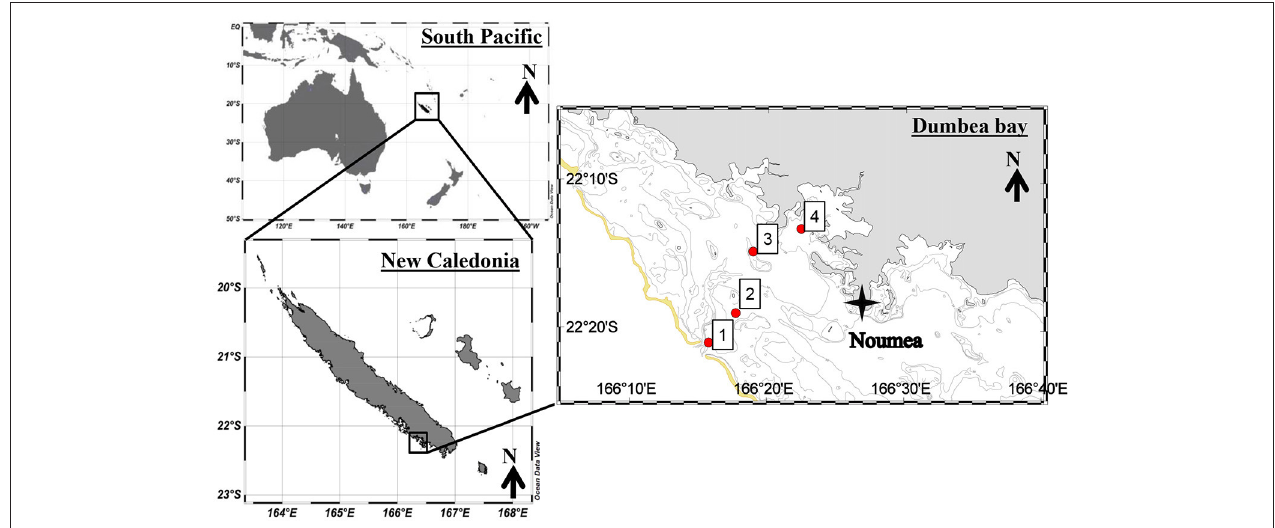
FIGURE 1 | Map of stations sampled in the New Caledonian lagoon. The yellow line represents the coral reef